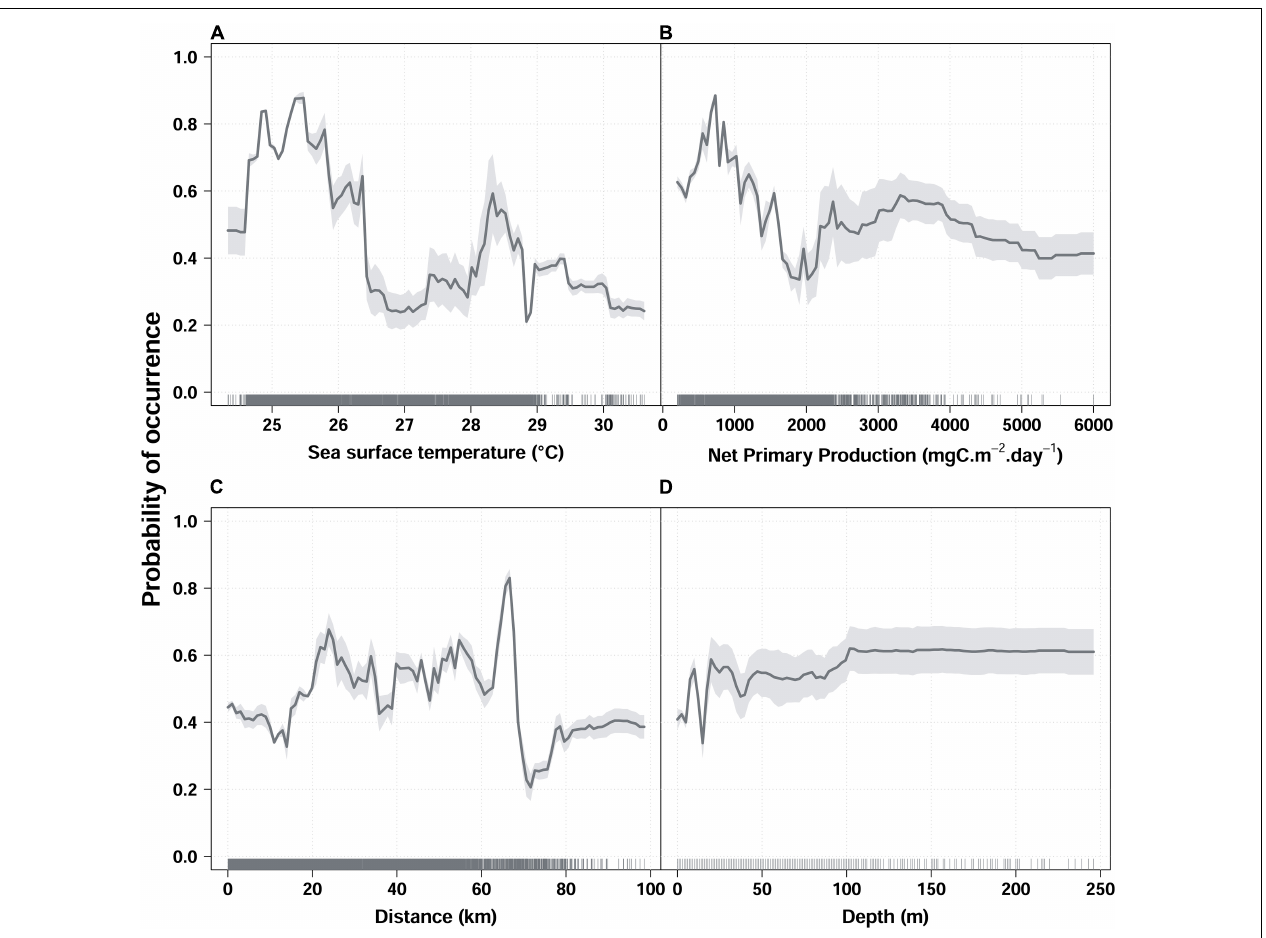
FIGURE 3 | Predicted response curves of SST (A) , NPP (B) , DIS (C) , and BAT (D) covariates. Each figure represents the expected contribution to the probability of occurrence of fishing activities while the other covariates were set constant to their mean